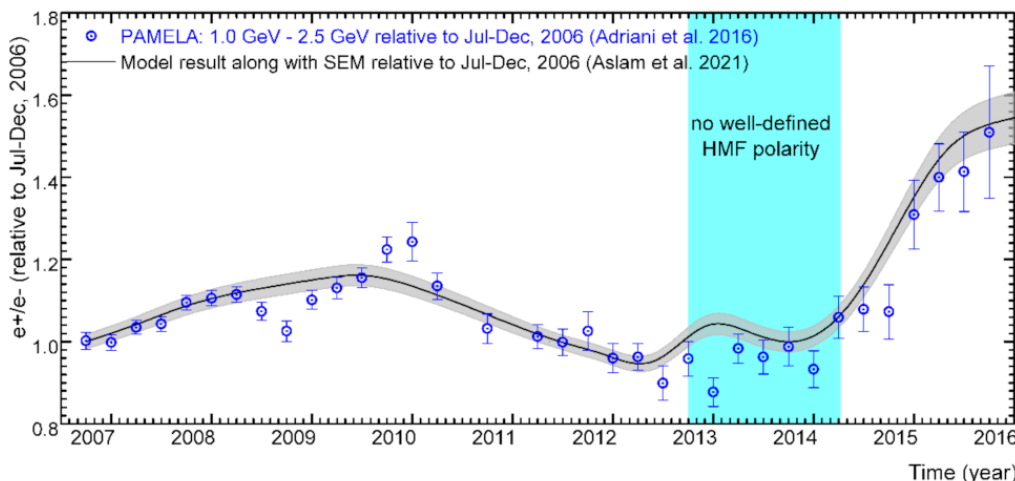
Figure 14. The simulated ( e + /e − ) ratio (black line with grey band) as a function of time (solar activity) based on reproducing the PAMELA observed ratio [2] here shown at 1.01–2.5 GeV (circled blue points with error bars) for this period. Vertical shaded band is as before. Modeling results are shown along with the standard error of mean (SEM; deviation/ amended from